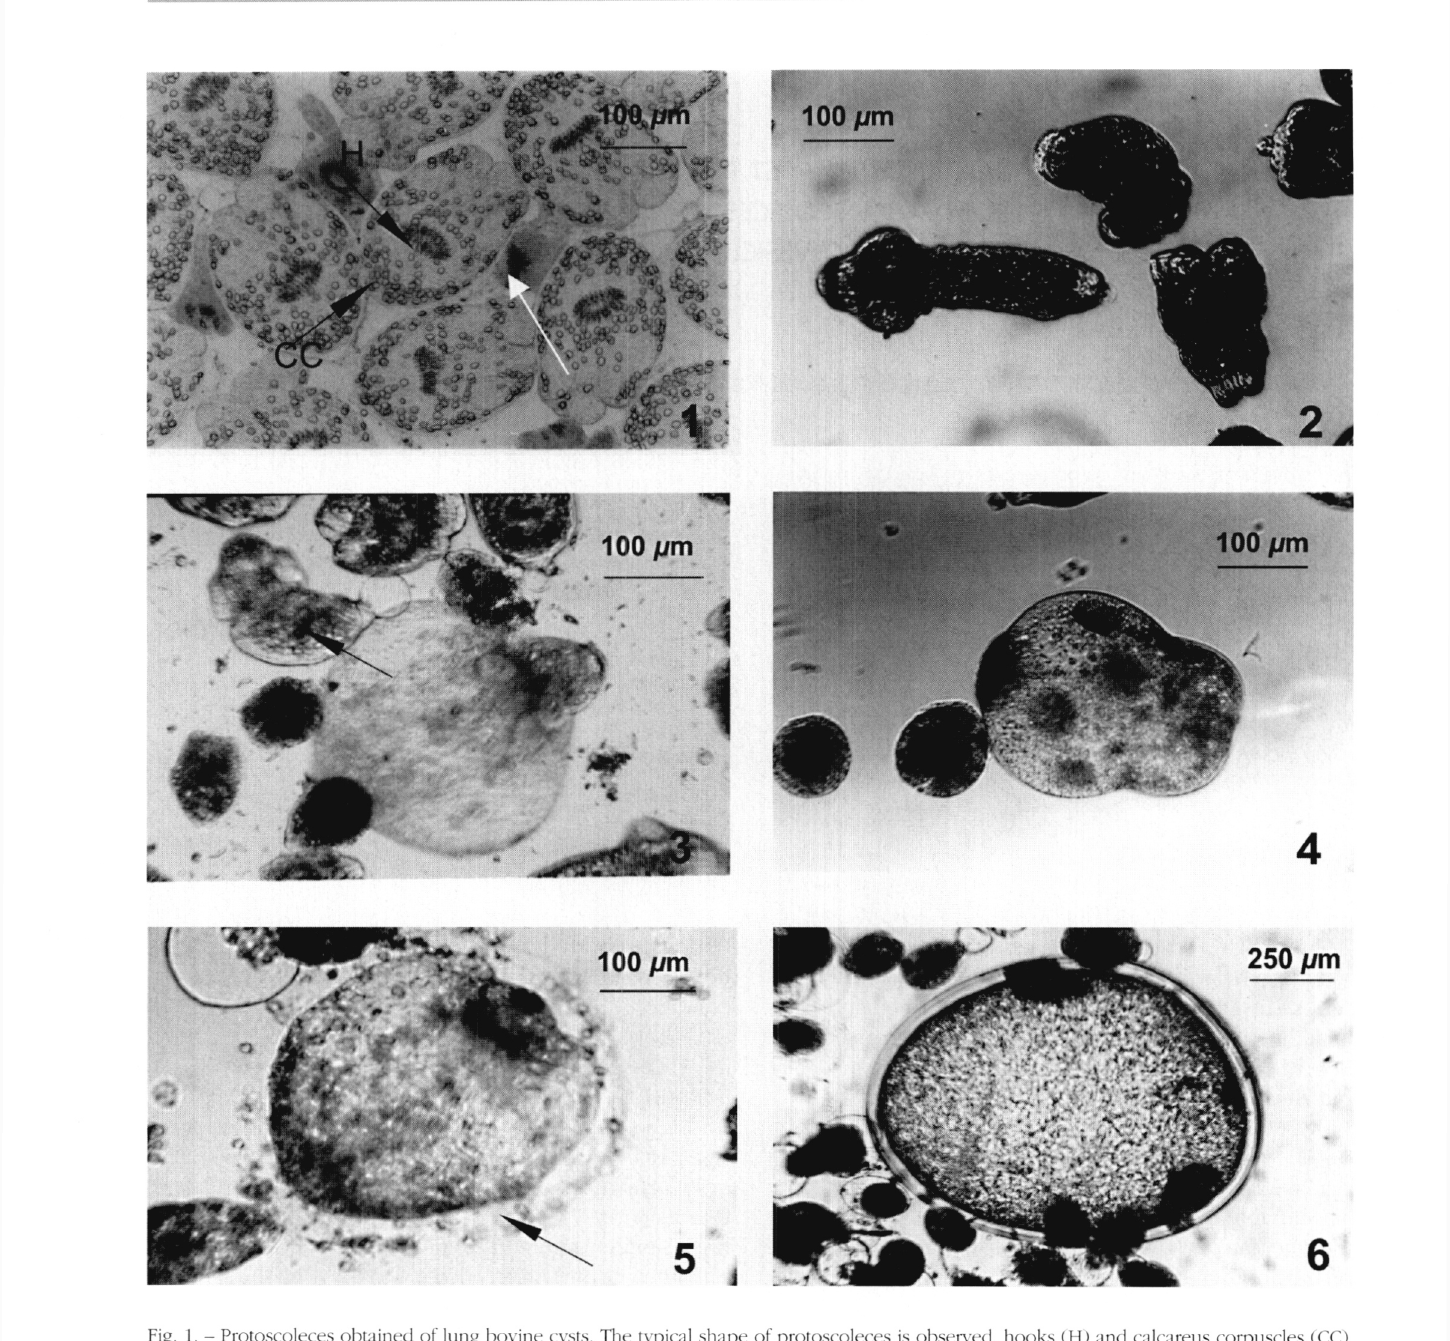
Fig. 1. - Protoscoleces obtained of lung bovine cysts. The typical shape of protoscoleces is observed, hooks (H) and calcareus corpuscles (CC). Dead stained protoscolece (white arrow). Methylene blue exclusion test 1:10.000. Fig. 2. - Evaginated protoscolece. Fig. 3. - Vesiculated protoscolece. An evaginated protoescolece showing a posterior bladder is observed (arrow). Fig. 4. - Vesiculating protoscolece (three days of culture). Note the increment in the size. Fig. 5. - Microcyst showing laminated layer (20 days of culture) (arrow). Fig. 6. - Microcyst completely developed (48 days of